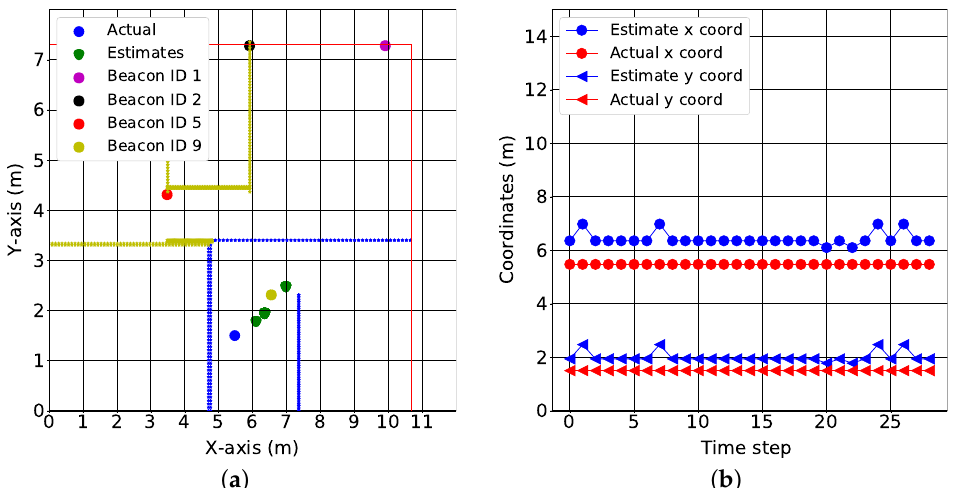
Figure 15. Testing in the kitchen. ( a ) Floor plan view, and ( b ) location estimates over time.